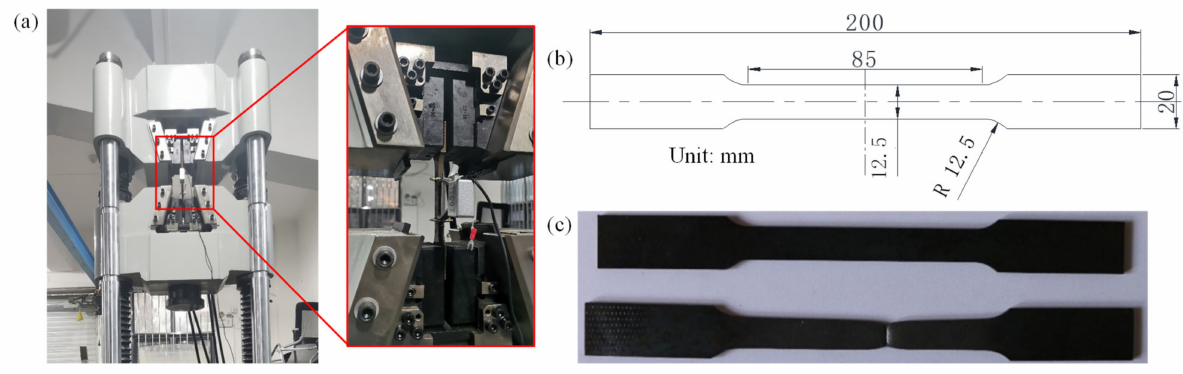
Figure 6. Quasi-static tensile test of the steel plates: ( a ) tensile test machine; ( b ) geometric configura- tions of the tensile specimen; ( c ) photograph of the tensile test